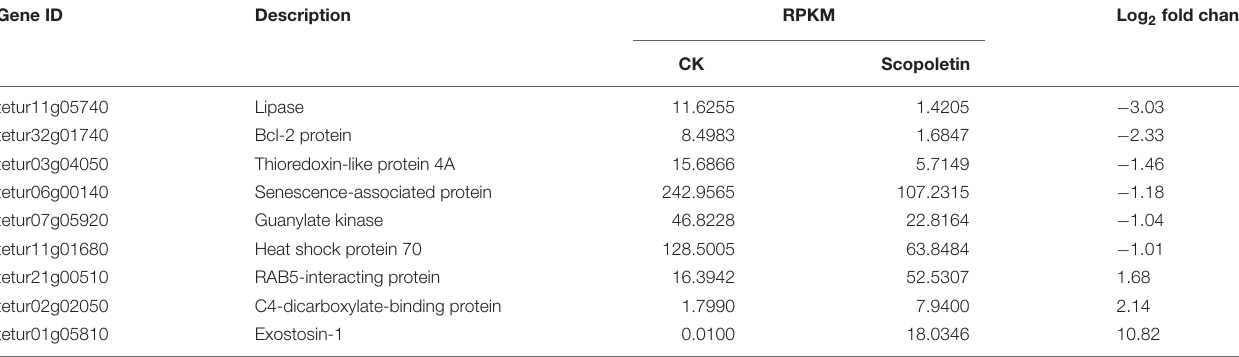
FIGURE 4 | KEGG pathway analysis of differentially expressed genes in T. cinnabarinus in response to scpoletin. (A) Top 20 enriched KEGG pathways of differentially expressed genes at 24 h posttreatment. (B) Top 20 enriched KEGG pathways of differentially expressed genes at 48 h posttreatment. Rich factor is defined by the ratio of the number of differentially expressed genes enriched in the pathway and the number of all genes enriched in the same pathway. TABLE 2 | Selected genes involved in mite detoxification and acaricide metabolism at 24 h